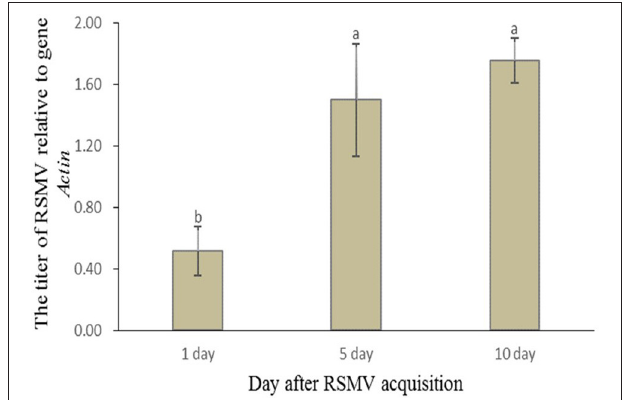
FIGURE 2 | Relative RSMV titer in R. dorsalis after its acquisition from rice plants. Accumulation levels of the virus in R. dorsalis were normalized relative to the Actin gene at different time points as assessed by RT-qPCR. Each histogram bar represents the RSMV’s relative mean titer from at least 30 individuals. Values followed by different letters represent significant differences based on a statistical analysis (SPSS 13.0) followed by Duncan’s multiple range test at P <